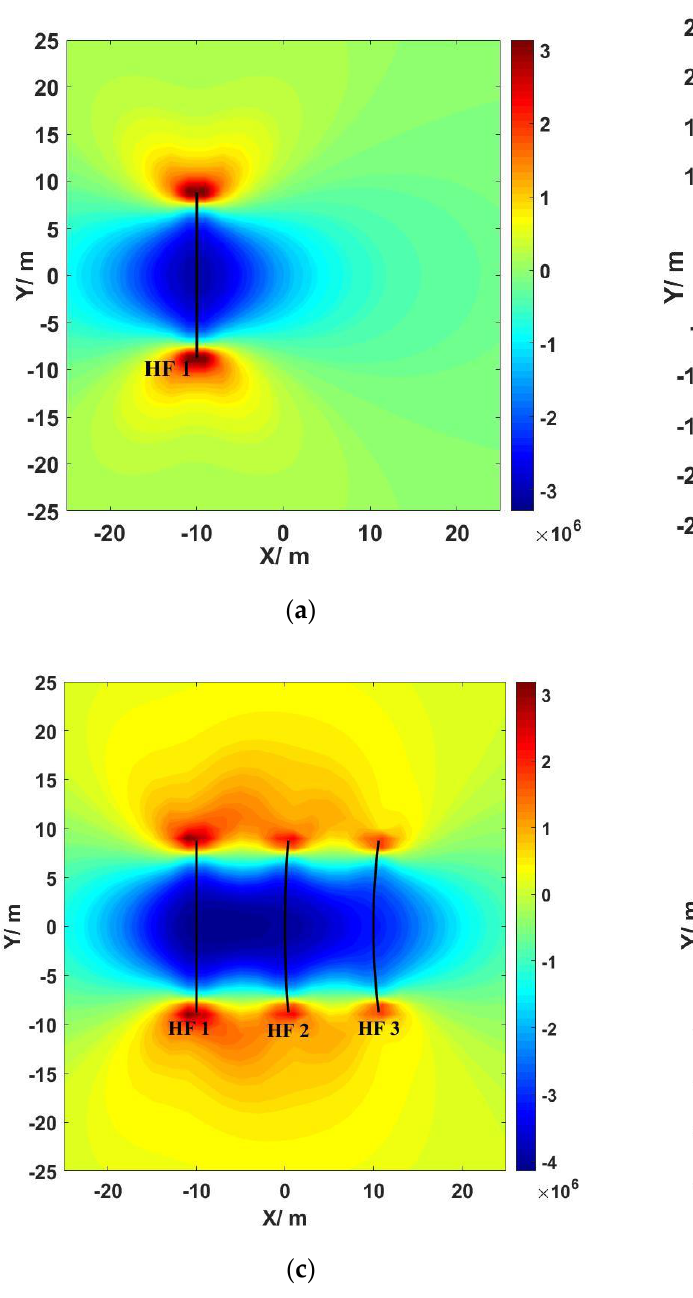
Figure 5. Numerical simulation results of fracture morphology and induced stress of ( a ) σ xx produced by residual aperture after completion of fracturing stage 1; ( b ) σ xx produced by residual aperture after completion of fracturing stage 2; ( c ) σ xx produced by residual aperture after completion of fracturing stage 3; ( d ) σ xy produced by residual aperture after completion of fracturing stage 1. In contrast, the fracturing HF may also affect the aperture of fractured HF. In order to quantitatively evaluate the aperture of HF 1 influenced by different fracturing stages, we conducted the following simulation, as shown in Figure